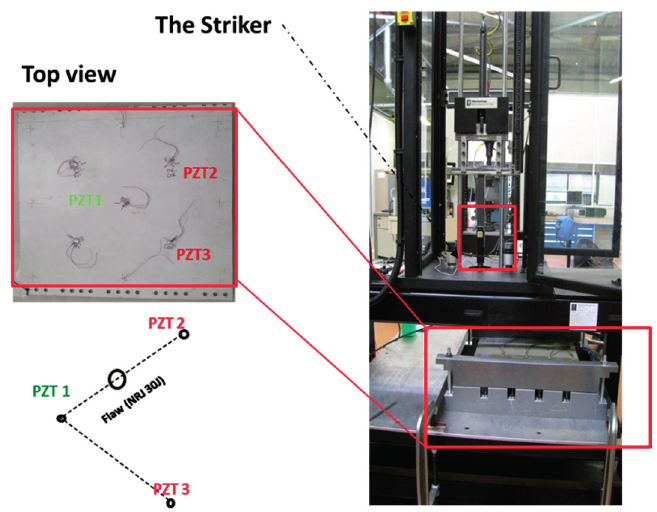
Figure 17. Experimental setup: The stimulus is generated by the PZT 1 and received by PZT 2 and